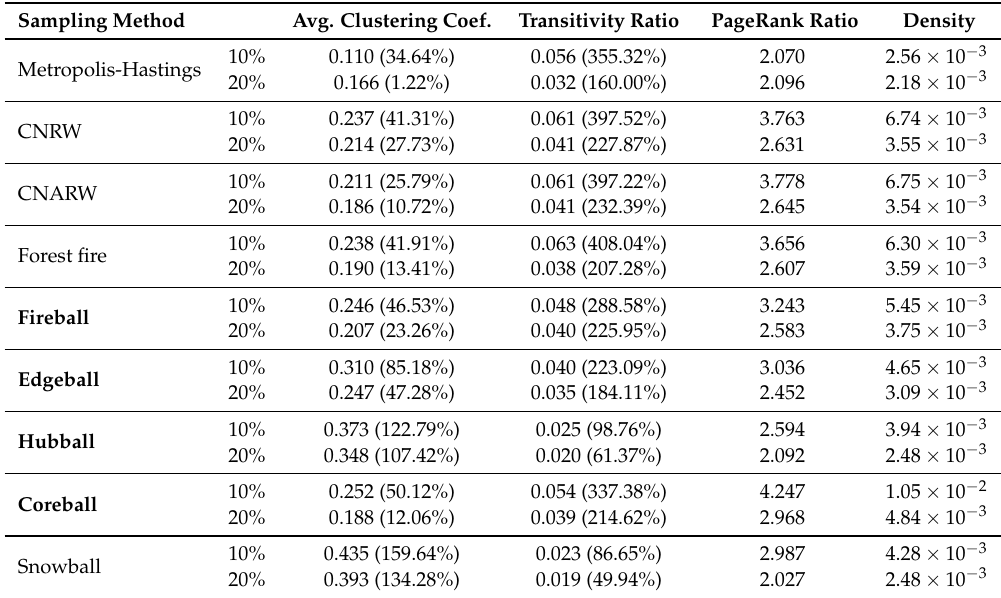
Table 4. Numerical results for the Github graph sampled at 10% and 20%. Full graph’s average clustering coefficient is 0.168, transitivity ratio is 1.24 × 10 − 2 , density is 4.07 × 10 − 4 . Relative error for the average clustering coefficient and transitivity ratio is shown between parentheses.